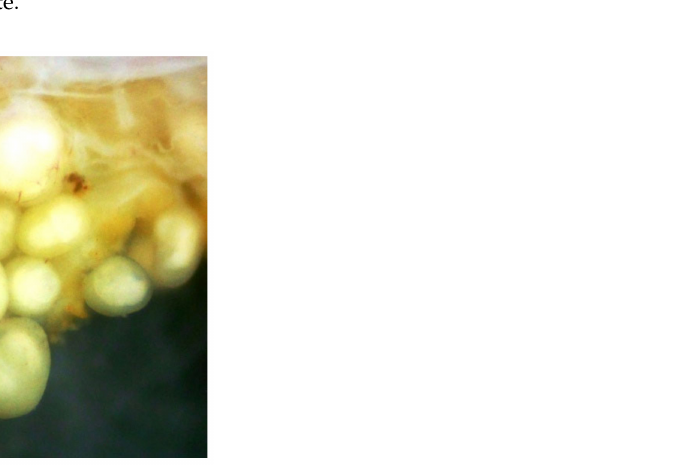
Figure 6. Cysts containing the cysticercoids of D . triseriale attached to the intestinal mesentery of S . maculata